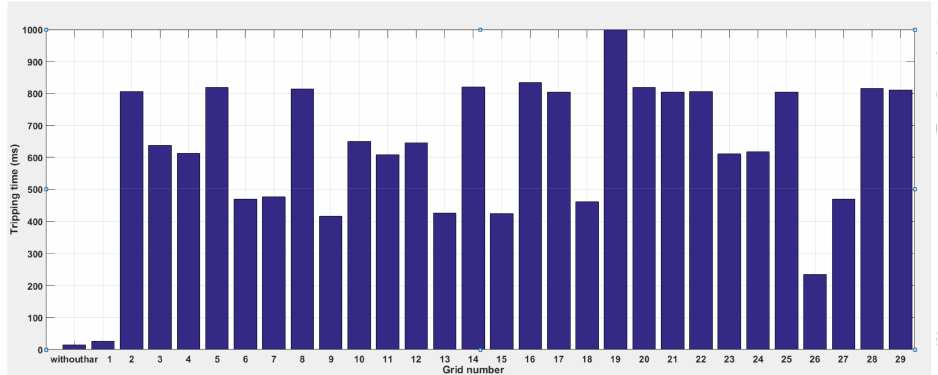
Figure 12. Distance relay: tripping time (seconds) vs. THD level of grids.